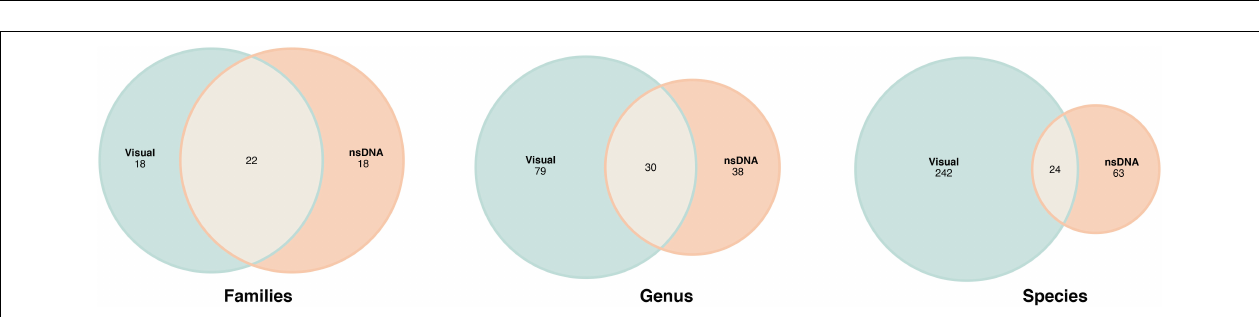
FIGURE 8 | Venn diagrams of the common families, genus and species recorded by visual census data reported in Van Nguyen and Kim Phan (2008) and nsDNA recovered from the study sponges in Nha Trang Bay.